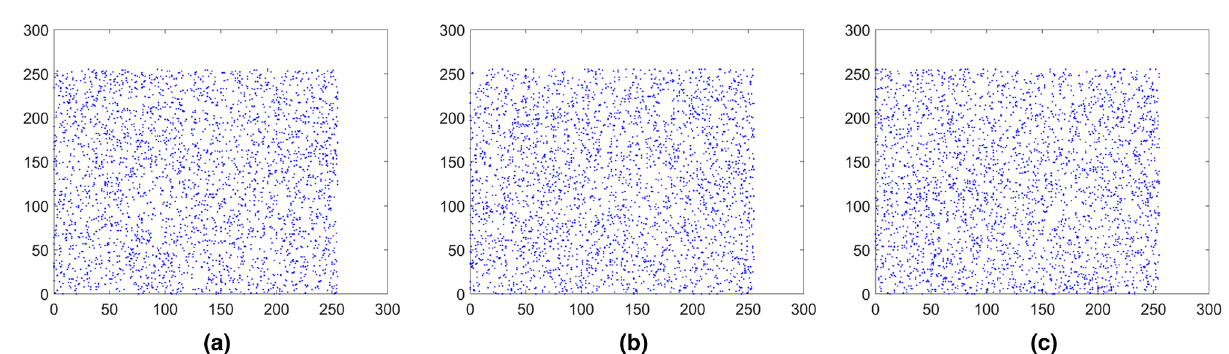
Figure 18. Distribution of adjacent pixels of the encrypted Black. ( a ) Horizontal direction of the encrypted image, ( b ) vertical direction of the encrypted image, (c) diagonal direction of the encrypted